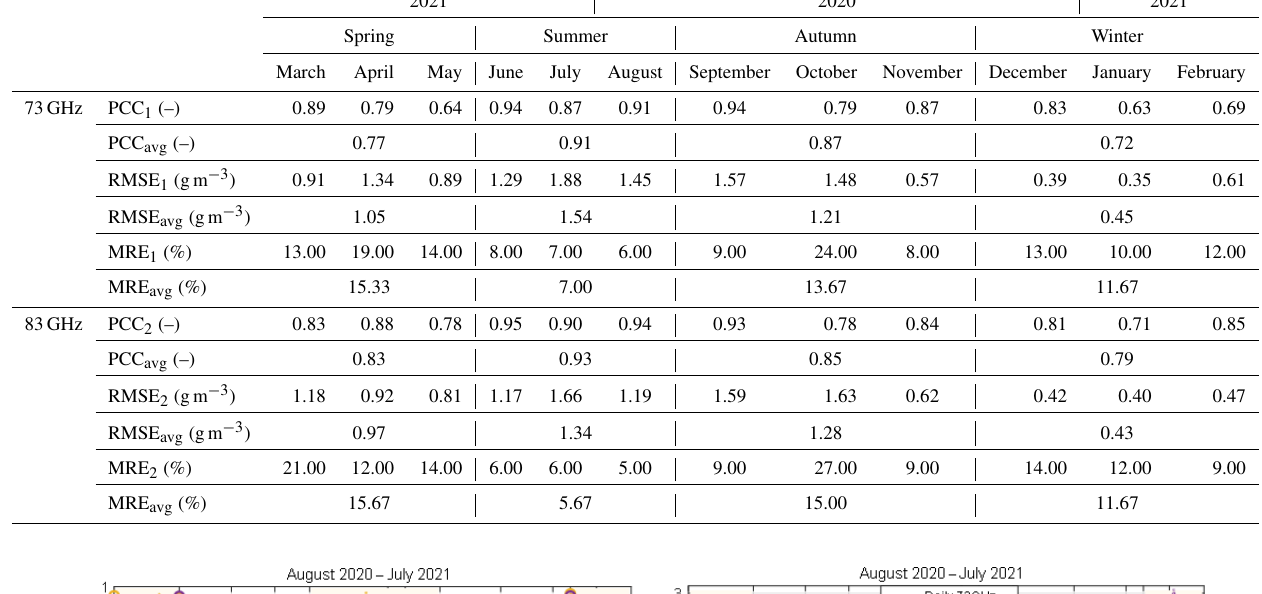
Table 2. Correlation, root mean square error, and mean relative error between the water vapor density obtained by millimeter wave links in different months and the measured value of the weather station, as well as the average value of each quarter.